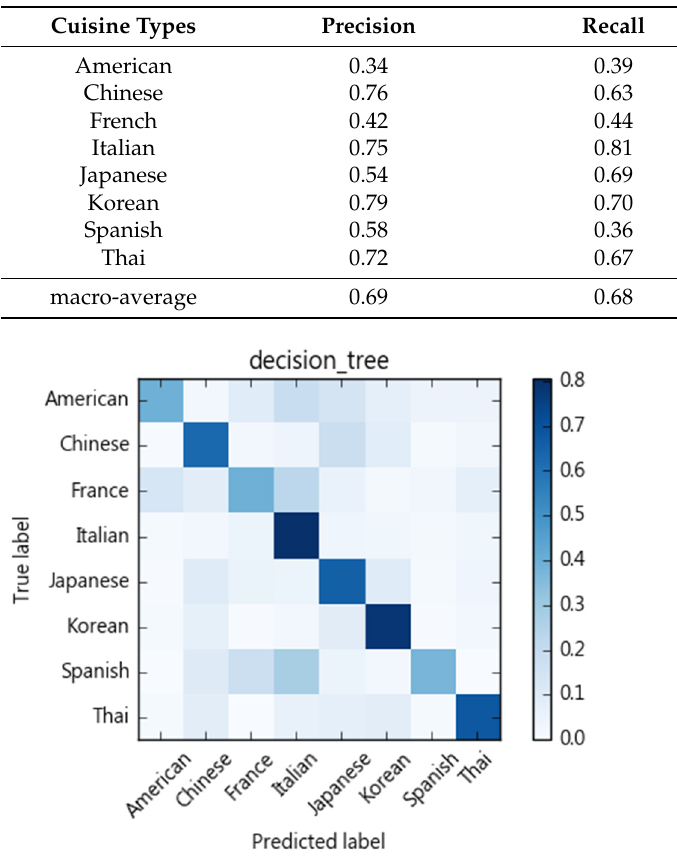
Table 6. Performance of the Decision Tree classifier.